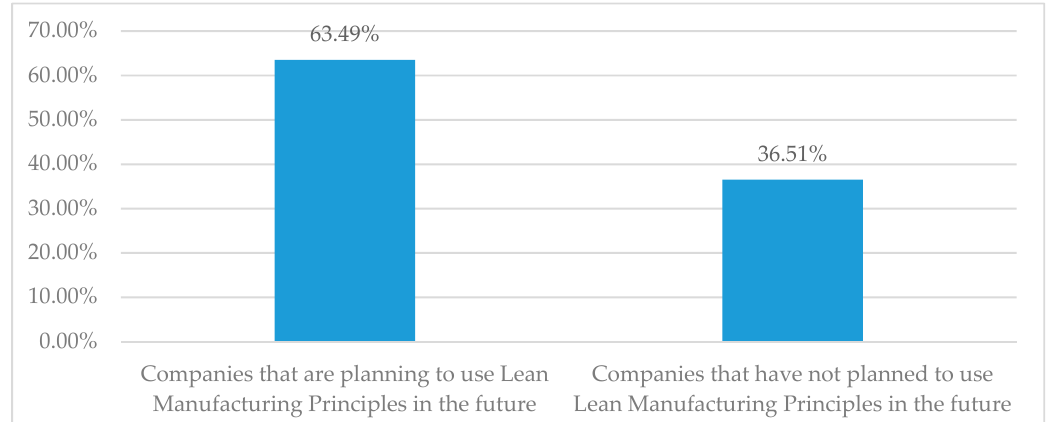
Figure 2. The percentage of companies that plan to use/not planned to use lean manufacturing principles in the future.